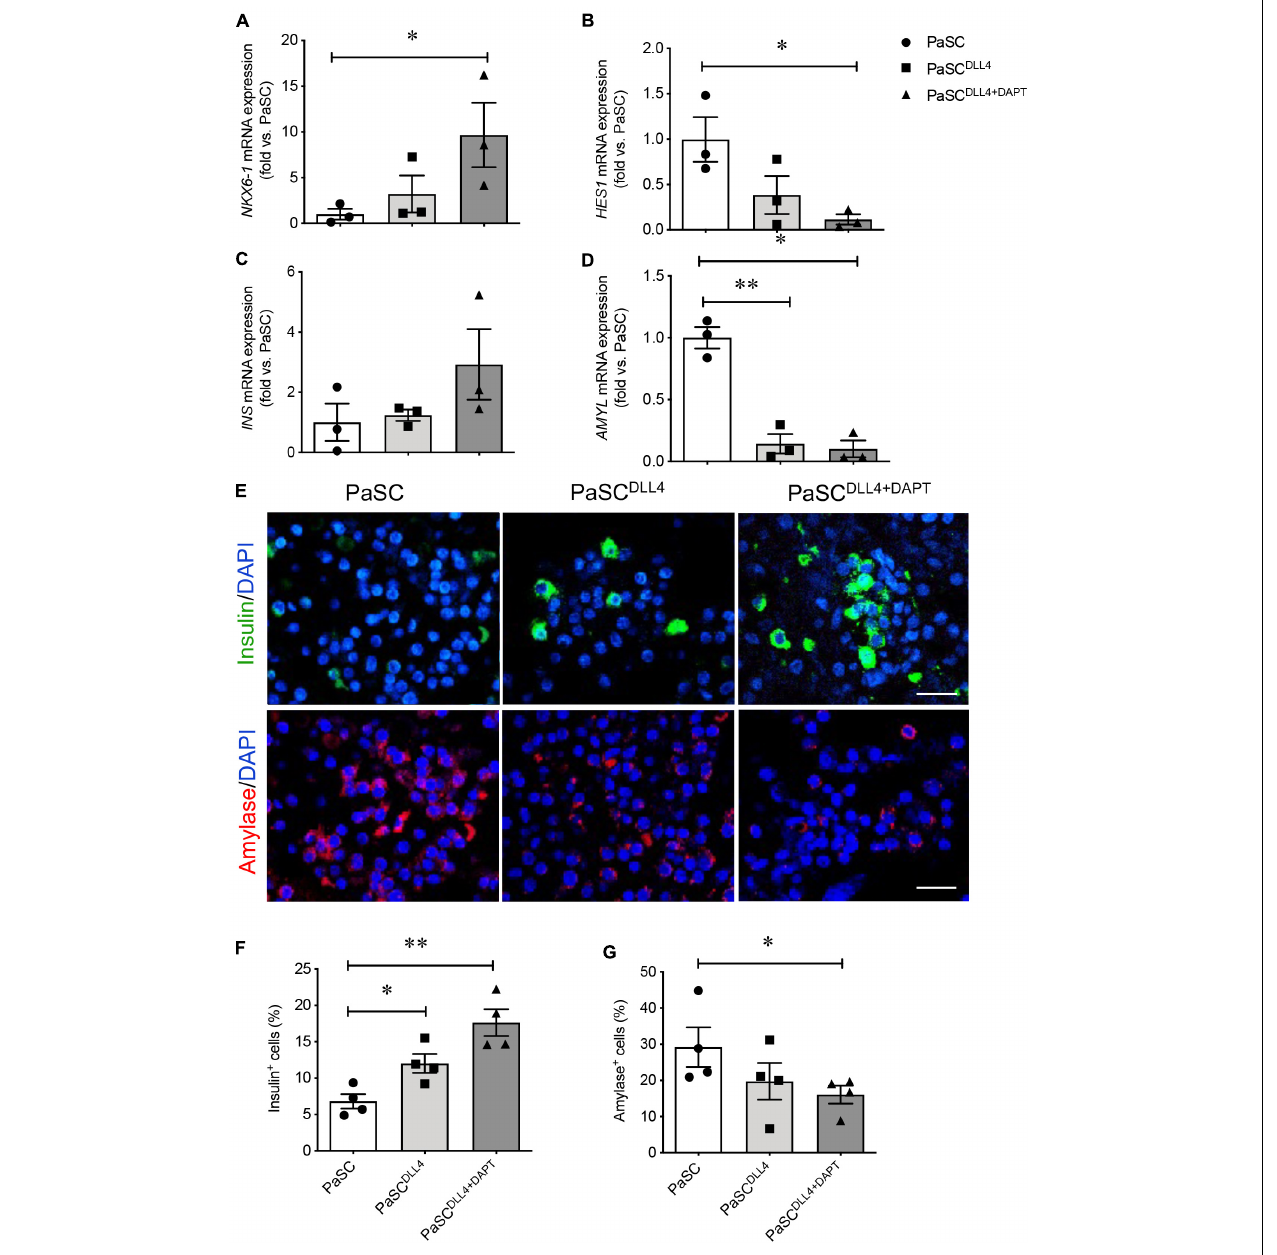
FIGURE 8 | Blockade of PaSC Notch signaling enhances beta cell differentiation in hIECCs during an indirect co-culture. qRT-PCR analysis of transcription factors (A) NKX6-1 , (B) HES1 , and pancreatic genes (C) INS and (D) AMYL . (E) Representative immunofluorescence images for insulin (green) and amylase (red); nuclei were labeled with DAPI (blue). Scale bar: 25 µ m. The quantification of (F) insulin + and (G) amylase + cells in hIECCs following an indirect Millicell insert co-culture with PaSCs pretreated with Notch inhibition (DLL4 antibody and DAPT). Closed circles, control (PaSC); closed squares, PaSC DLL4 ; closed triangle, PaSC DLL4 + DAPT . Data are expressed as mean ± SEM ( n = 3–4 experiments/treatment group). ∗ p < 0.05, ∗∗ p < 0.01; analyzed using one-way ANOVA with Tukey’s post hoc